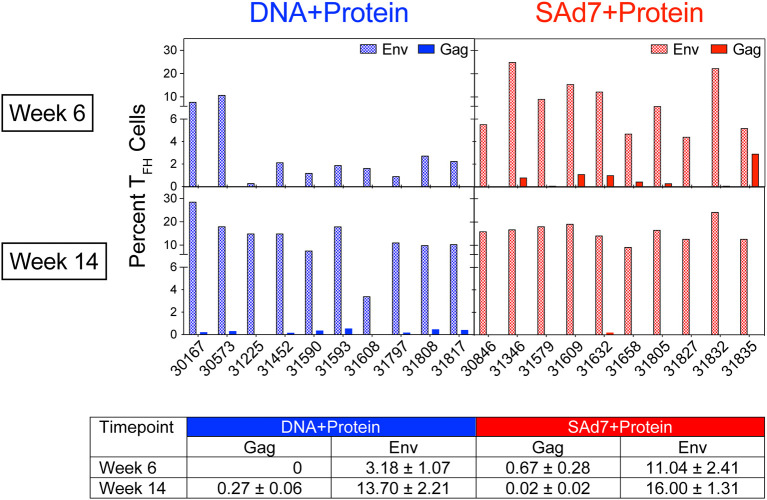
Env-specific and Gag-specific CD4 TFH responses. Two weeks after the second and third immunizations, frequency of CD4 TFH in inguinal lymph nodes was assessed after stimulation with CAP257 54wpi_D Env trimeric glycoprotein or a pool of 125 SIVmac239 Gag open reading frame (ORF) 15-mer overlapping peptides. Data are expressed as percentage of functional CD4 TFH cells stimulated by vaccine immunogens. Tabulated data show mean +/- SEM.